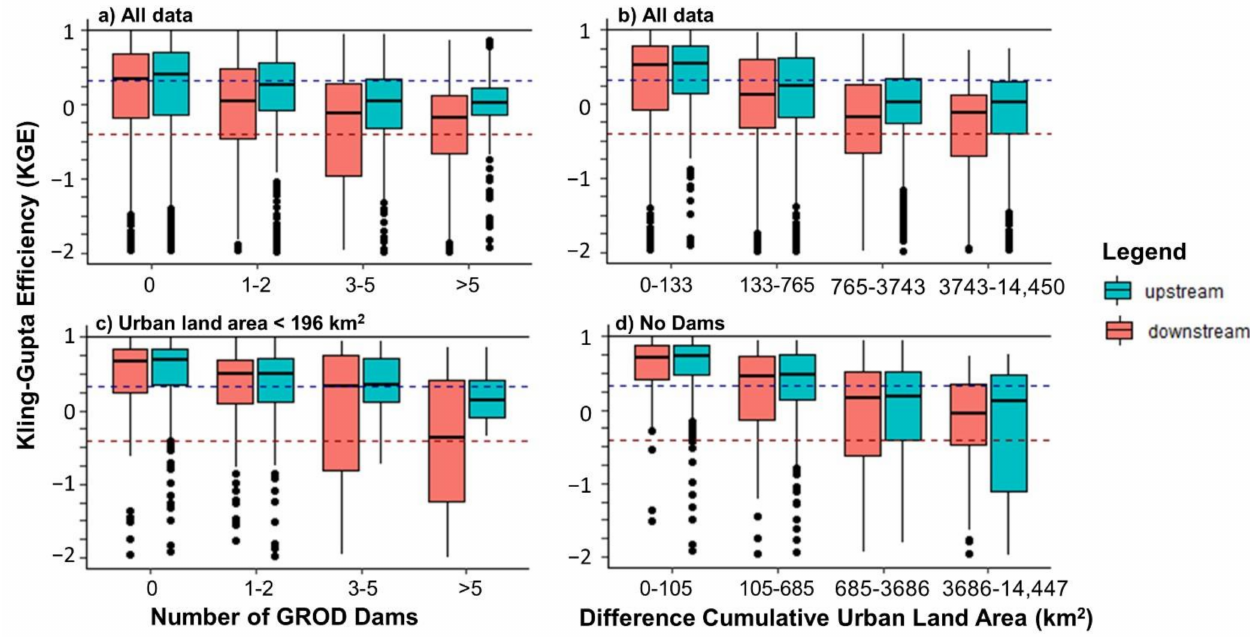
Figure 7. Boxplots for ( a ) the number of GROD dams per gauge comparison for all 4344 potential donations, ( b ) the difference in cumulative urban land area between gauges for all 4344 potential donations with each boxplot representing 25% of possible results, ( c ) the number of GROD Dams per gauge comparison for only the 1340 results with less than 196 km 2 of urban land area between gauges, and ( d ) the difference in cumulative urban area between gauges for only the 1412 results without any GROD dams between gauges with each boxplot representing 25% of possible comparisons. For all panels, the black horizontal line at 1 indicates the optimal KGE value, the blue dashed line indicates the study’s defined “good” KGE value of 0.32, and the red dashed line is at KGE = − 0.41, the threshold for the metric where the model improves upon the mean flow benchmark. Boxplots are split into donations upstream vs. donations downstream between